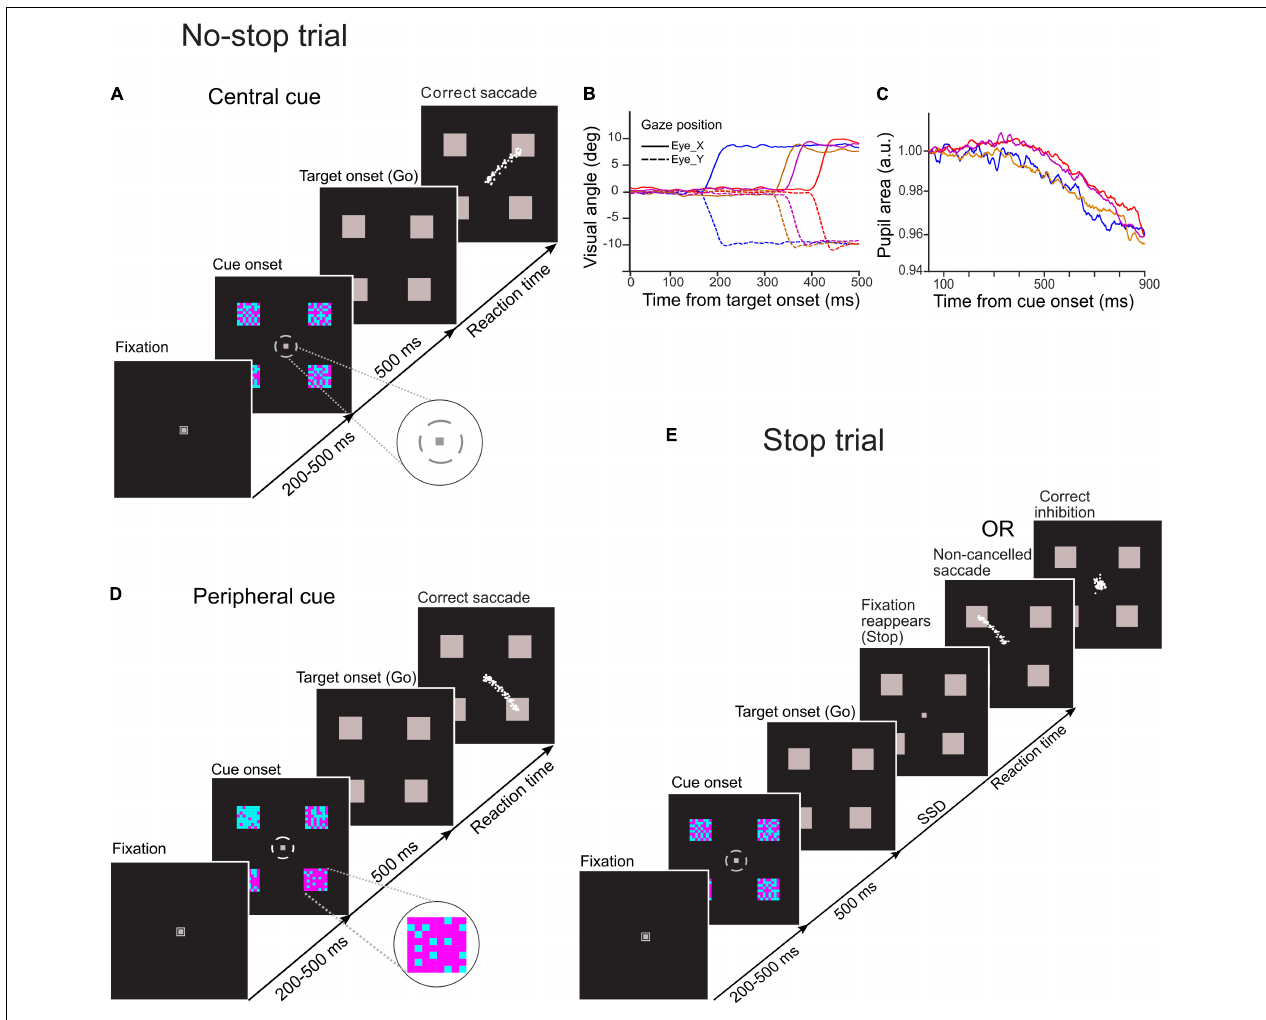
FIGURE 1 | Schematic of temporal sequence of events in novel choice-countermanding (CC) tasks. Following the fixation duration, four cyan-magenta checker boxes appeared peripherally along with a small gray broken circle around the fixation spot. After 500 ms, the fixation spot and the broken circle disappeared, and all four peripheral checker boxes were masked by gray squares simultaneously (go-signal). (A) In the central cueing task, in the majority (60%) of trials (no-stop trials), participants were instructed to select the largest circumferential gap of broken circle (magnified in the inset) and to orient the gaze to one of the squares in the direction of the largest gap. (D) In the peripheral cueing task, in 60% of total trials (no-stop trials), participants were asked to select the checker box with the largest proportion of magenta color (magnified in the inset) and to orient their gaze to the location of the selected target following the disappearance of the fixation spot within a predetermined fixed period. Eye traces from representative saccades in no-stop trials are shown by white dots. (E) In the remaining trials (40%) of each task (stop trials), the fixation spot reappeared after a random delay [i.e., stop-signal delay (SSD)] to instruct participants to withhold their eye movements. No-stop and stop trials were randomly interleaved in each task. Gaze position and the pupillary response from representative trials are demonstrated in panels (B,C) ,